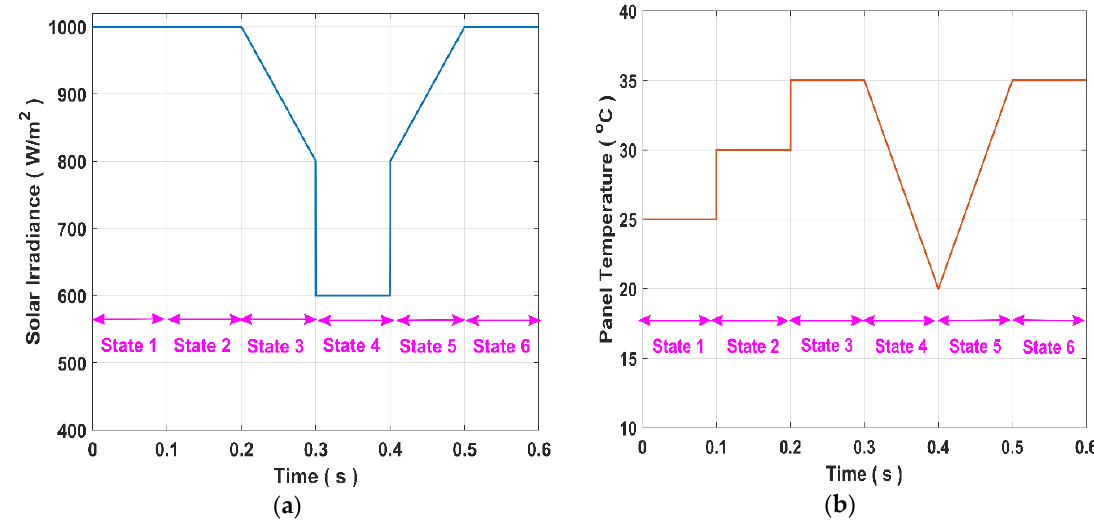
Figure 10. Extreme environmental conditions solar irradiance ( a ) panel temperature ( b ) for case 2.